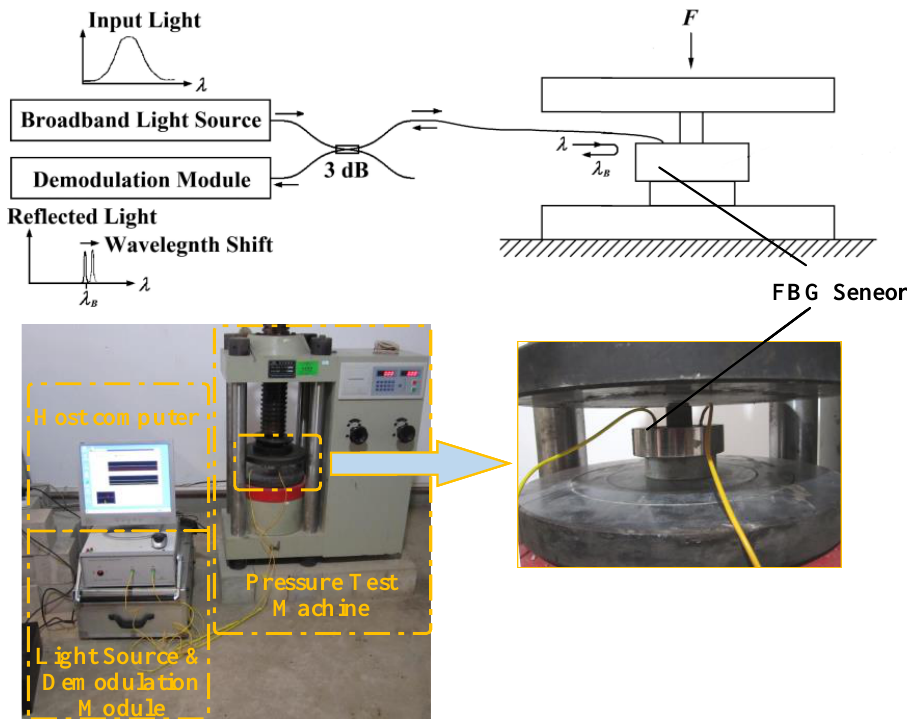
Figure 2. Pressure testing digram of spoke-type fiber Bragg grating stress sensor.